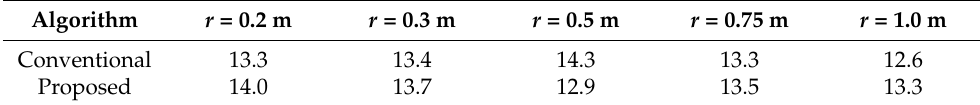
Table 3. Mean angular errors ( ◦ ) across all directions and judgments at different target